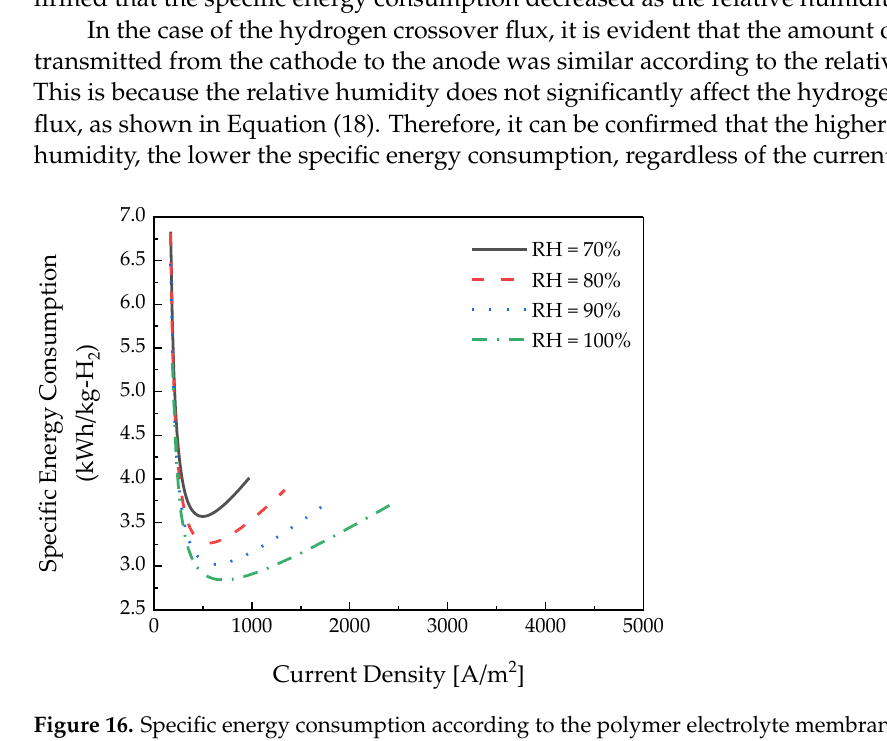
Figure 16. Specific energy consumption according to the polymer electrolyte membrane